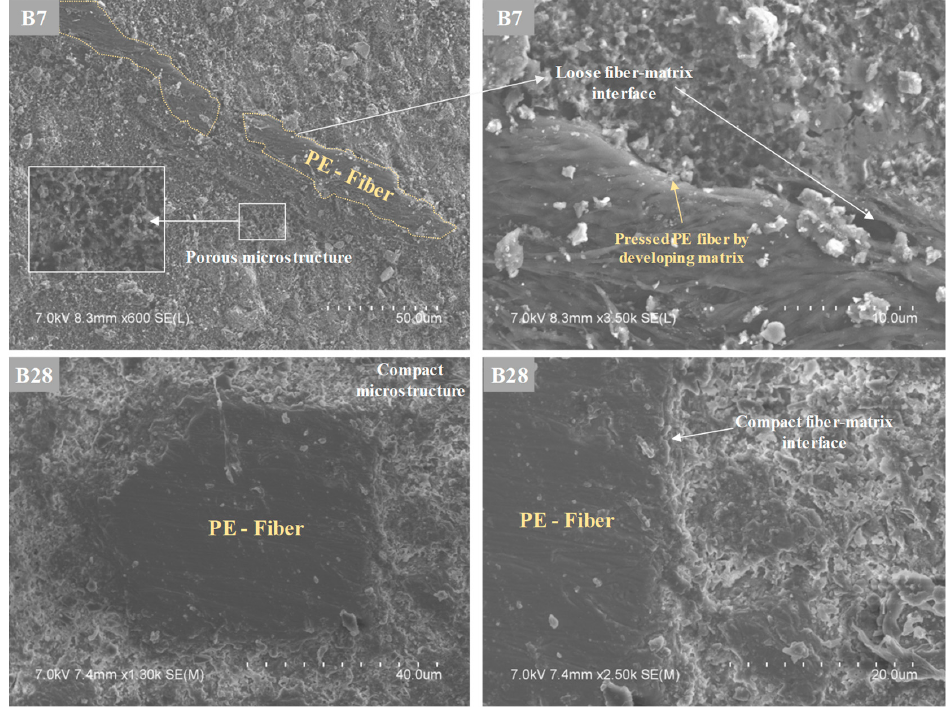
Figure 5. SEM images on the microstructure of specimens B7 and B28.